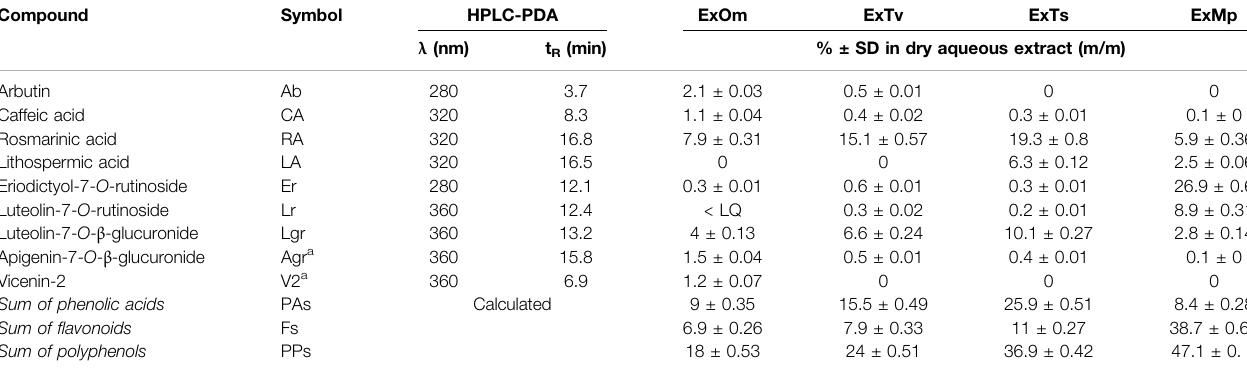
TABLE2| Polyphenolcontents(%)indriedaqueousextractsfromsweetmarjoram(ExOm),commonthyme(ExTv),wildthyme(ExTs),andpeppermint(ExMp)(asheatmap). Compound